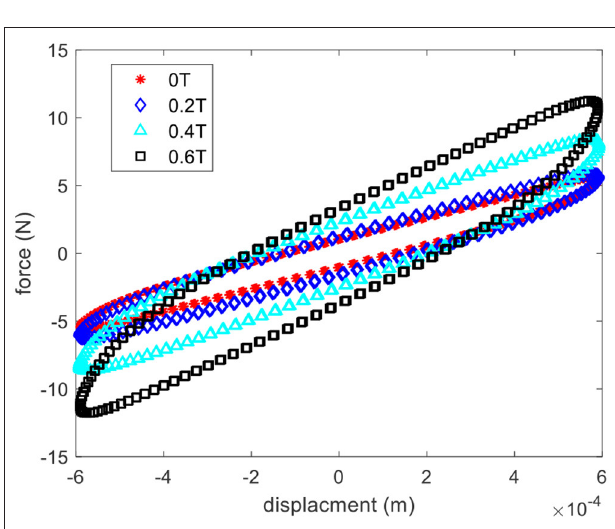
FIGURE 2 | The force with respect to displacement under different levels of applied magnetic flux density and fixed frequency of 1Hz.